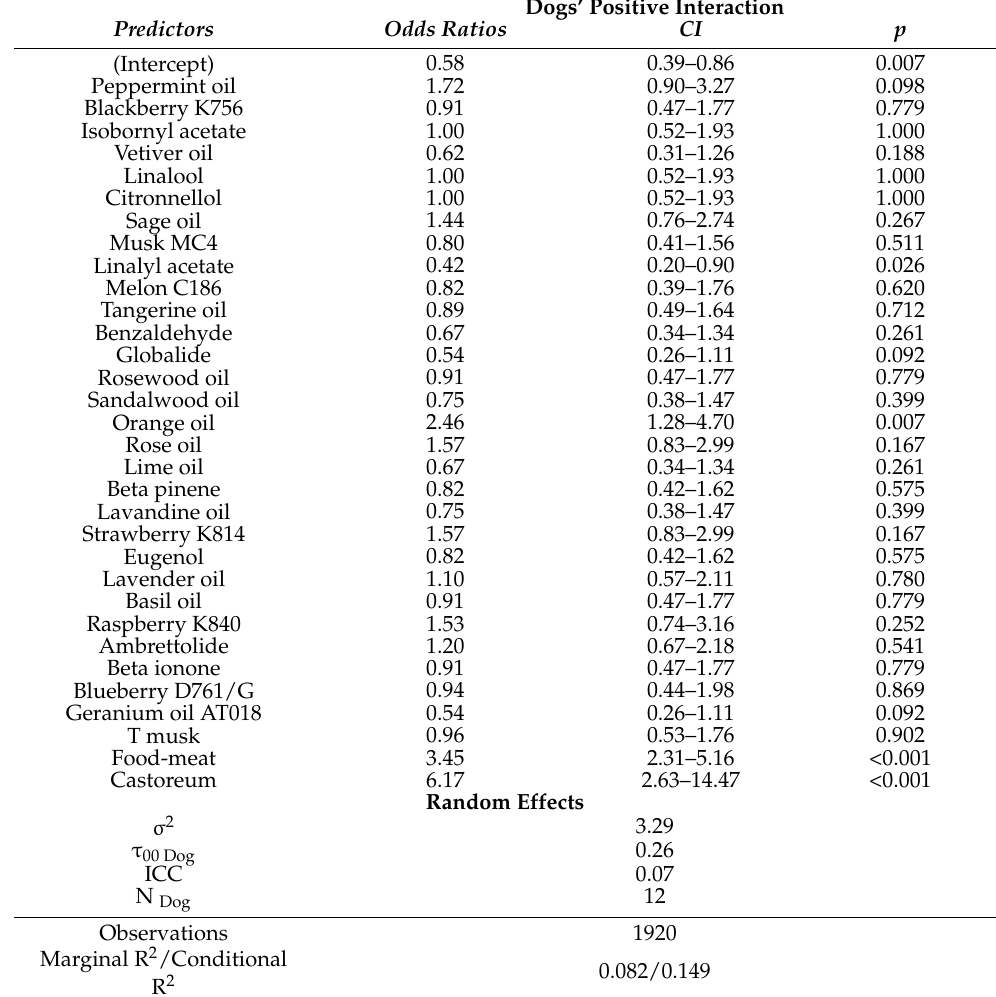
Table 3. Dogs’ positive interaction—sniffing activity (Yes/No): generalized linear mixed model displaying associations between sniffing activity (outcome) and administered odors (covariates), with dogs’ IDs as a random factor and glycol as the reference category.